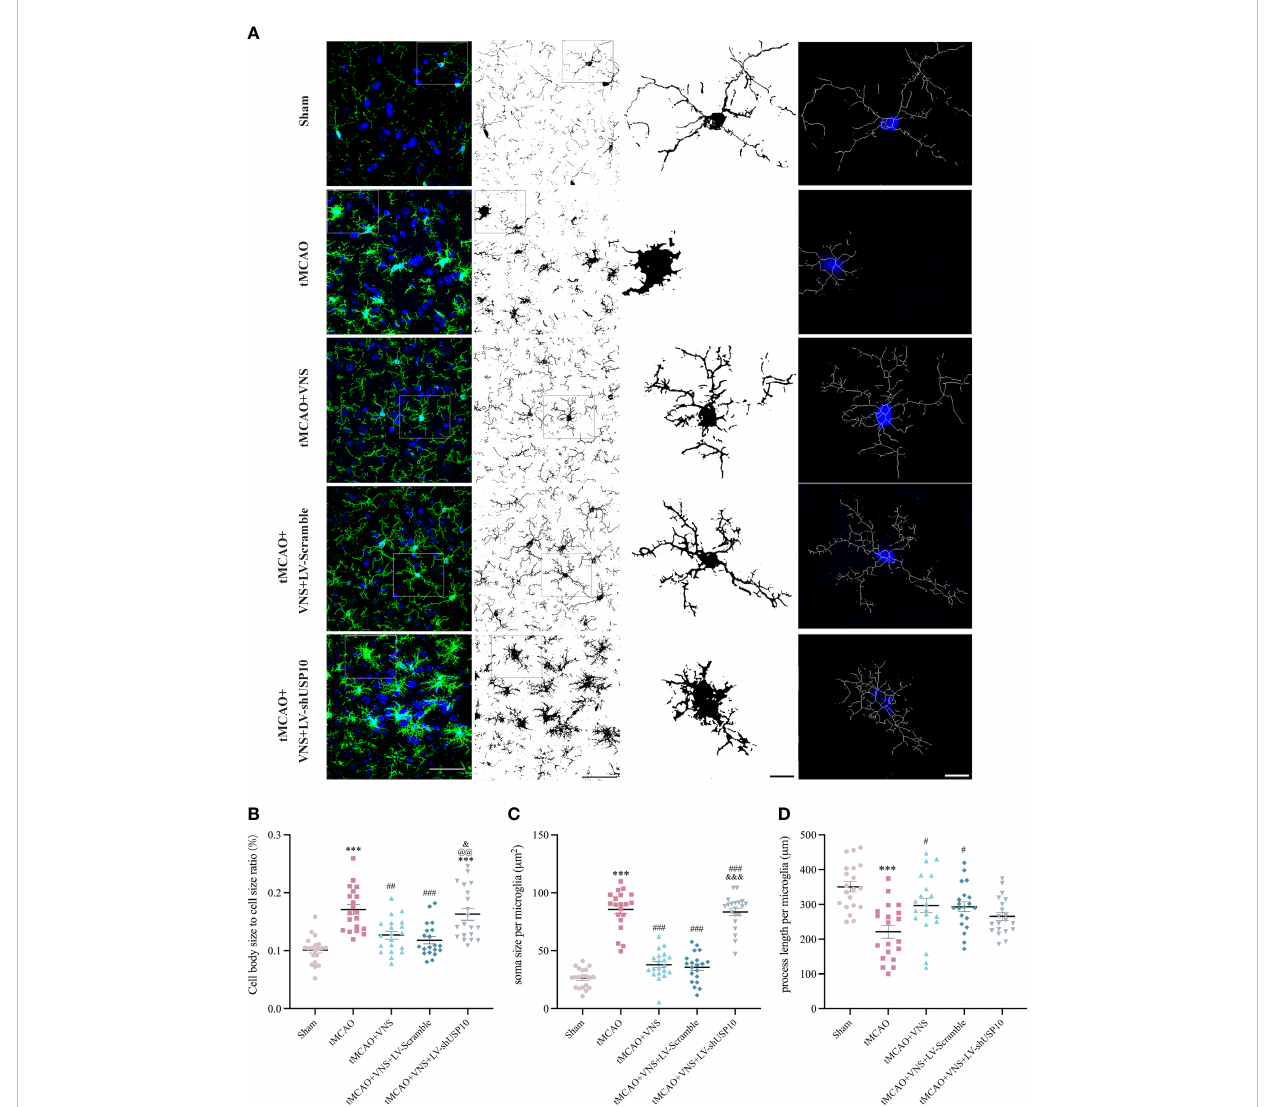
FIGURE 4 Quanti fi cation and illustration of morphological characteristics of microglia following skeleton reconstruction. (A) Graphical illustration of soma size cell body size, and process length of microglia for each group. Left column: maximum intensity projection of Z-stack images (blue: nuclei identi fi ed with the fl uorescent DNA stain DAPI; green: microglia marker Iba-1). n=20; Right three columns: the skeleton reconstruction. Scale bar (Left two columns) =50 m m, Scale bar (Right two columns) =10 m m. (B) The quanti fi cation of cell body size to cell size ratio (%). (C) The quanti fi cation of process length per microglia. (D) The quanti fi cation of soma size per microglia. Data are mean ± SEM. ***P<0.001 vs. Sham group, ###P<0.001, ##P<0.01, and #P<0.05 vs. tMCAO group. @@P<0.01 vs. tMCAO+VNS group. &&&P<0.001, and &P<0.05 versus tMCAO+VNS+LV-Scramble